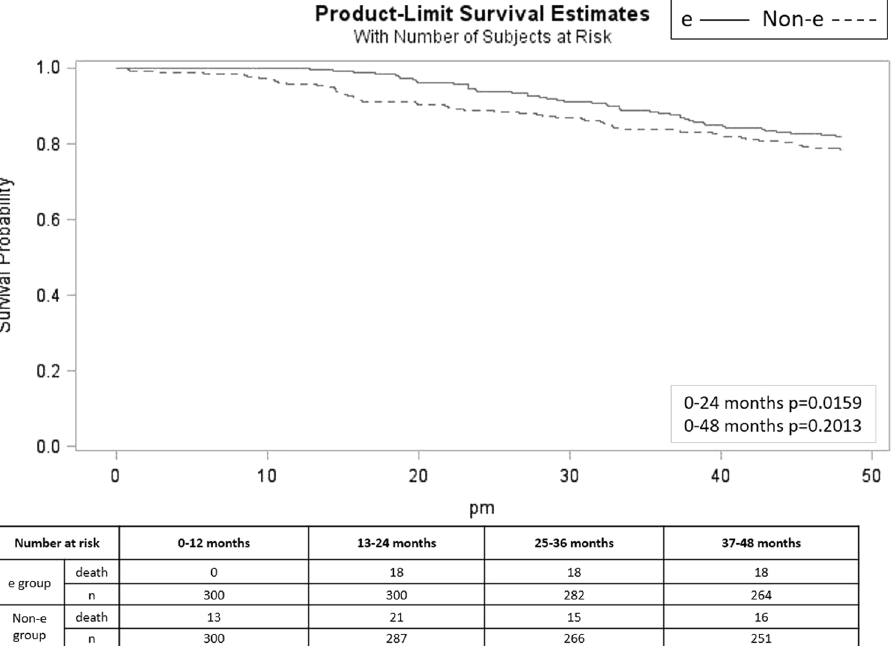
Figure 1. Survival functions Kaplan-Meier survival analysis in the 600 patients according to e-intervention or not showed four-year survival curve and number at risk table.